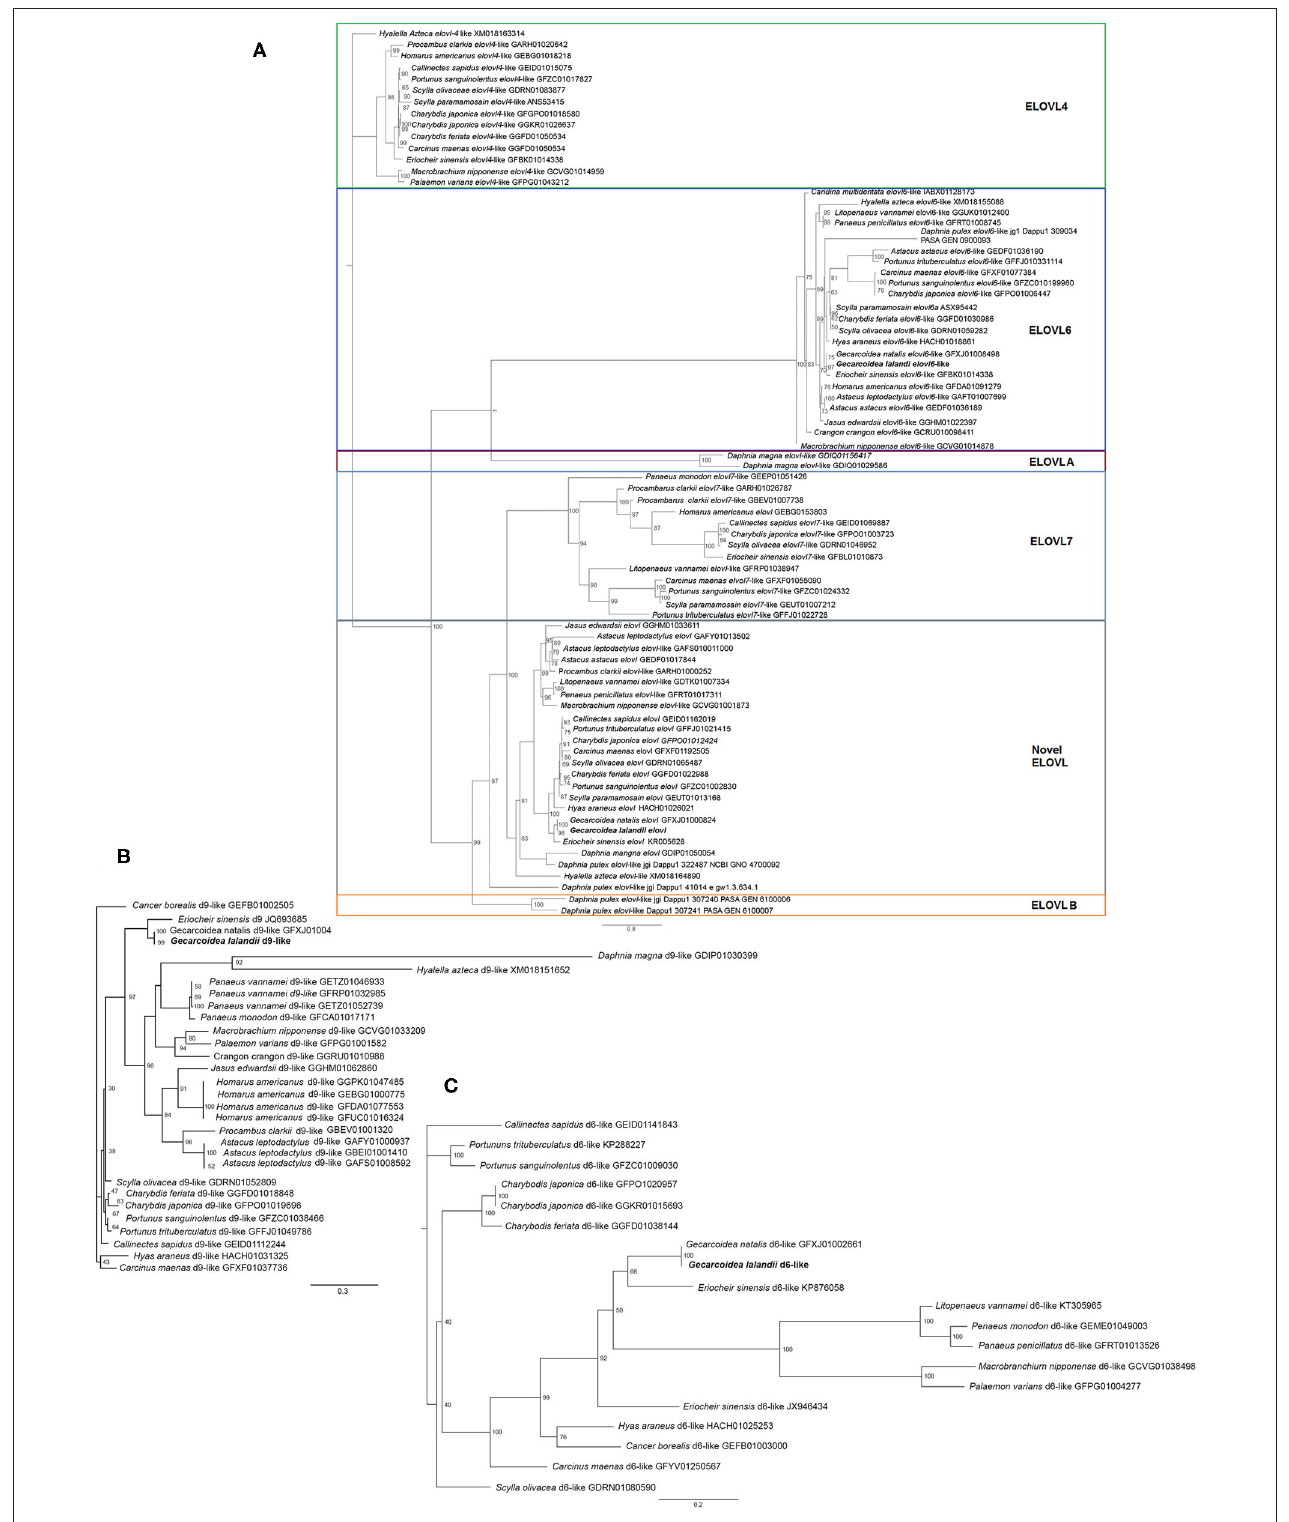
FIGURE 1 | Phylogenetic analyses of crustacean (A ) elongase (VT + I + G4, bootstraps value = 1,000), (B) acyl-CoA desaturase 9 (LG + G4, bootstraps value = 1000), and (C) delta-6 desaturase (JTTDCMut + I + G4, bootstraps value = 1000) sequences using IQ-TREE v1.6.12. The different colored boxes were drawn to facilitate viewing of the different elongase